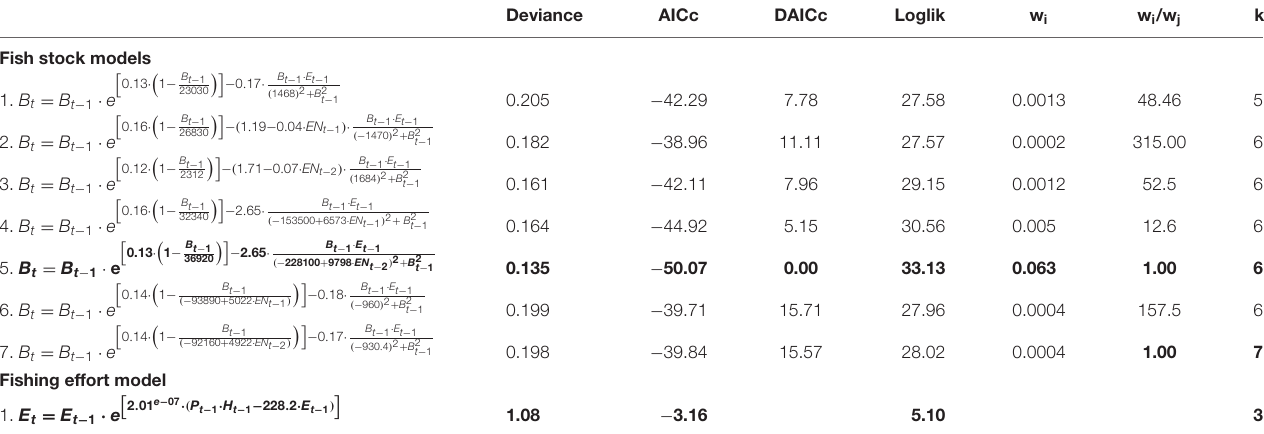
TABLE 2 | Population dynamic models for the Jake mackerel biomass, the fishing effort and prices. Deviance AICc DAICc Loglik w i w i /w j k